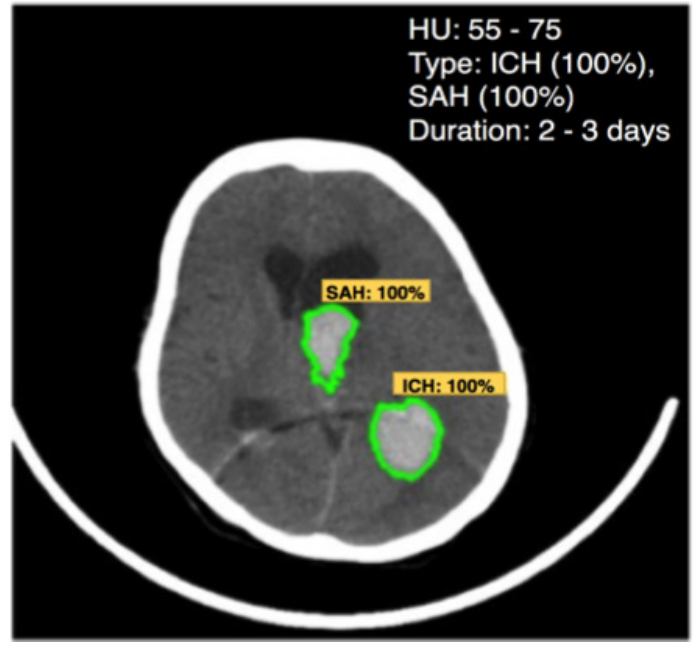
Figure 15. Multi- brain hemorrhages